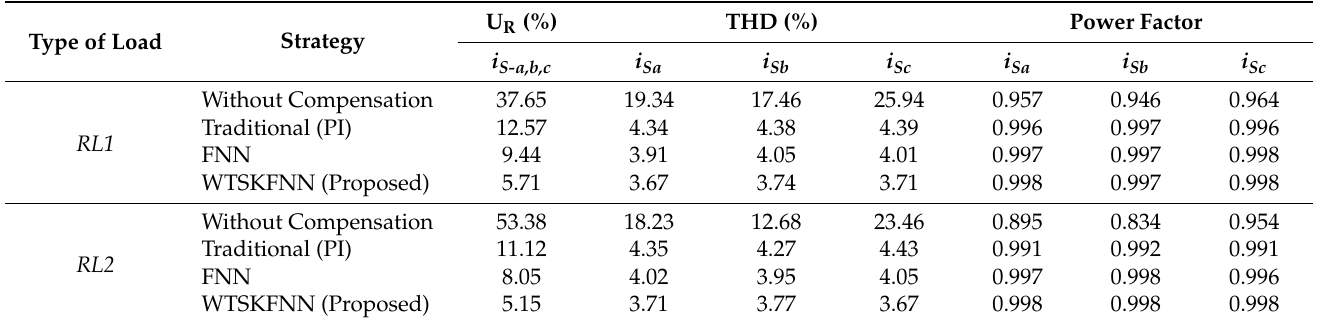
Figure 8. Experimental results using proposed WTSKFNN-controlled DSTATCOM at RL2. ( a ) Response of grid currents and neural current; ( b ) Response of phase- a grid voltage, phase- a grid current, and phase- a load current; and ( c ) Response of compensation currents and DC-link voltage of DSTATCOM. Table 2. Summary of unbalanced current ratio, PF, and THD of three-phase grid currents at Load RL1 and Load RL2